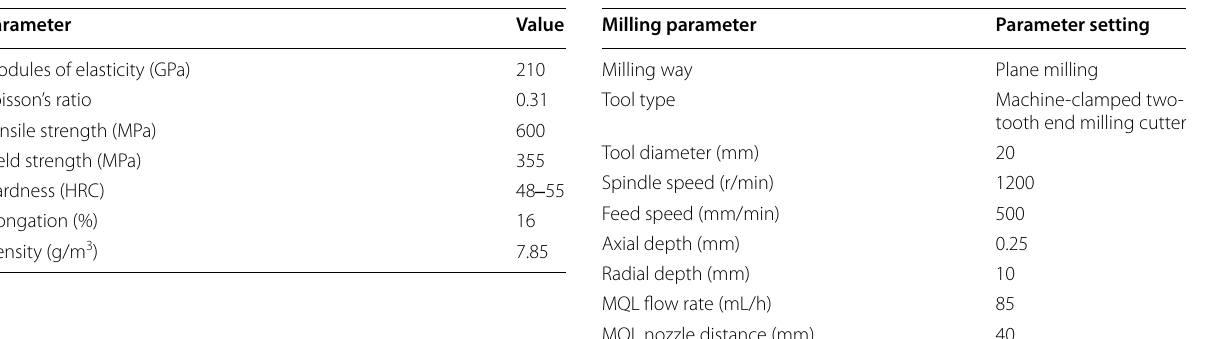
Table 3 Properties of Al